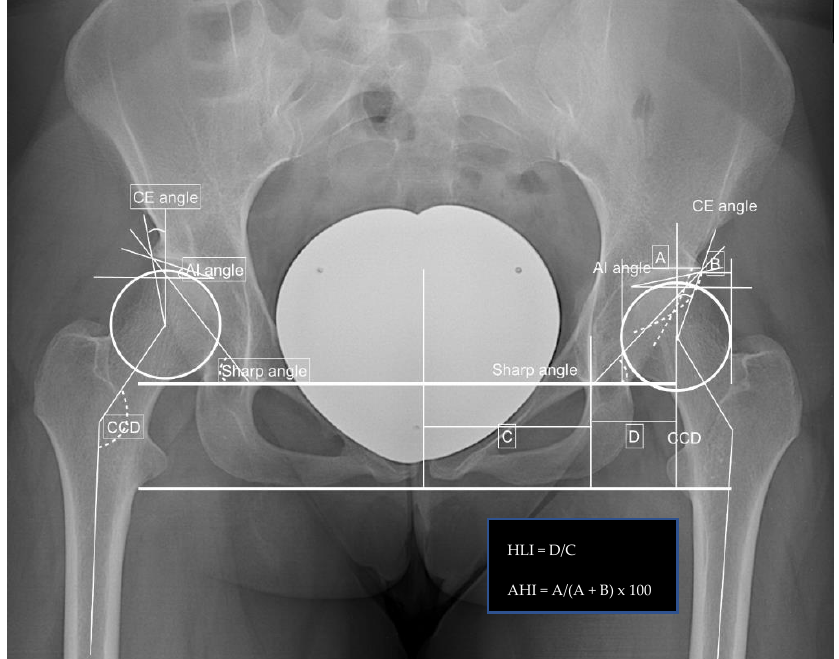
Figure 2. Preoperative findings and measurements performed; left side: CE angle 18.8°, AIA 12.3°, sharp angle 43.9°, hip lateralization 0.54, anterior hip index 73.9, CCD angle 137.4°, and positive crossing-over sign.